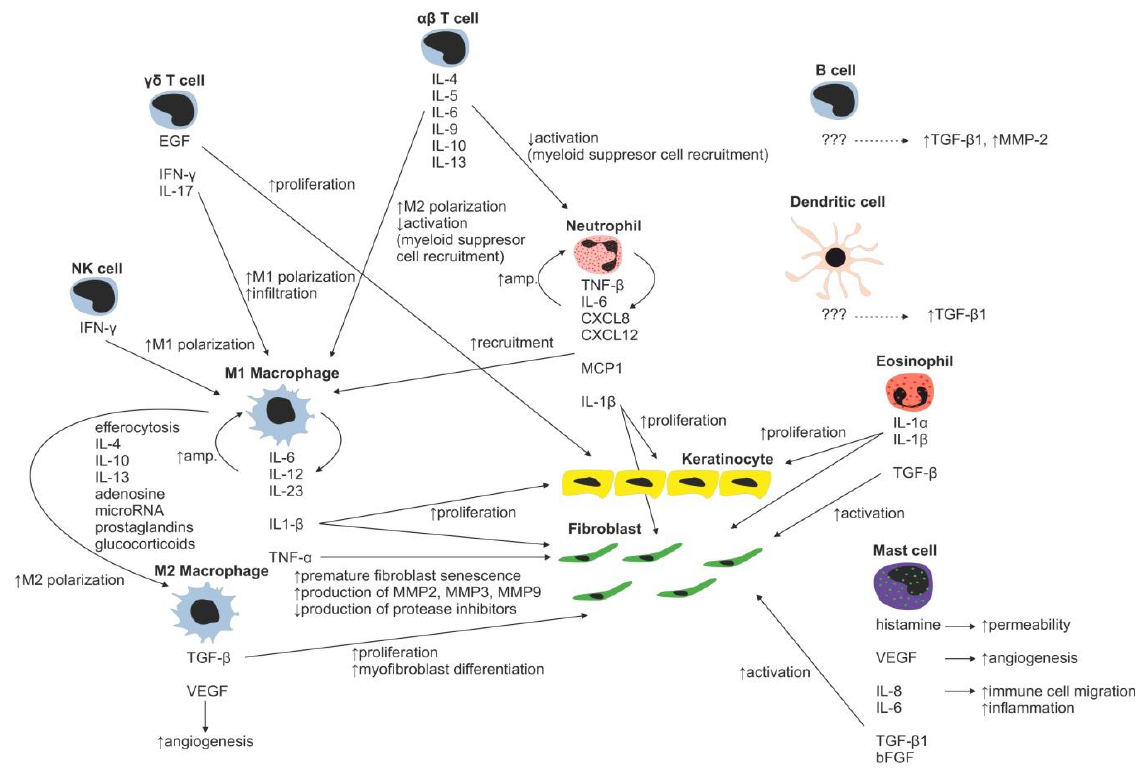
Figure 3. Immune cell regulation of normal wound healing.